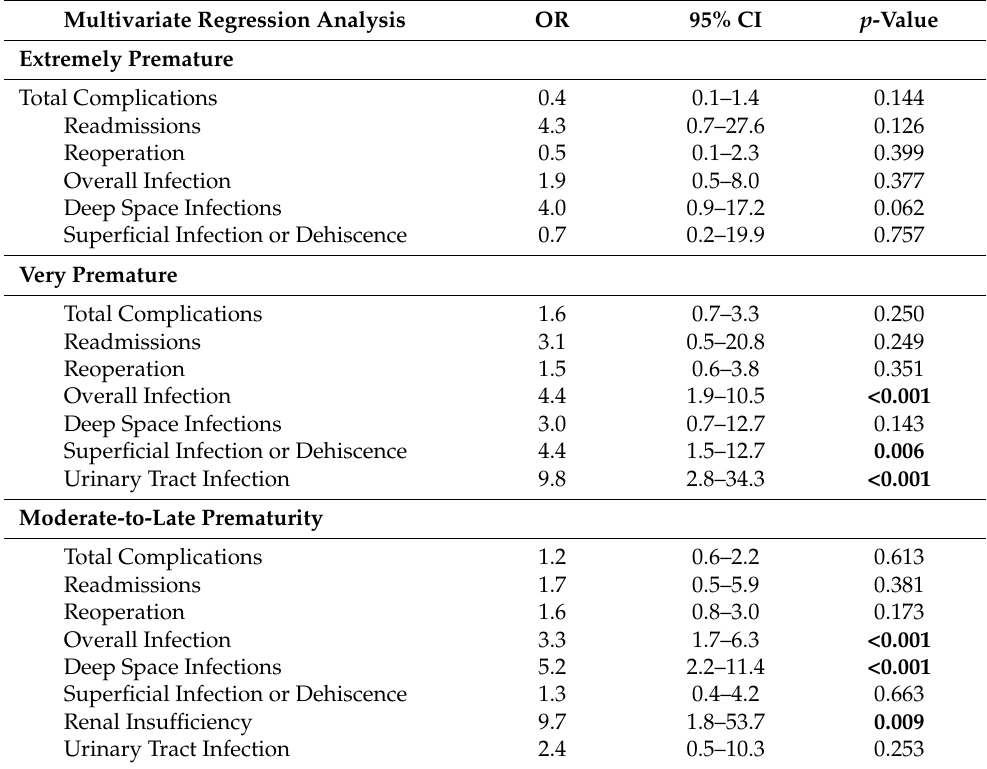
Table 7. Extremely premature (<28 weeks), very premature (28 ≤ x < 32 weeks), and moderate-to- late prematurity (32 ≤ x < 37 weeks) as predictive factors for 30-day postoperative complications, readmission, and reoperations in premature patients who underwent PSF for AIS. Bold values are statistically significant ( p <